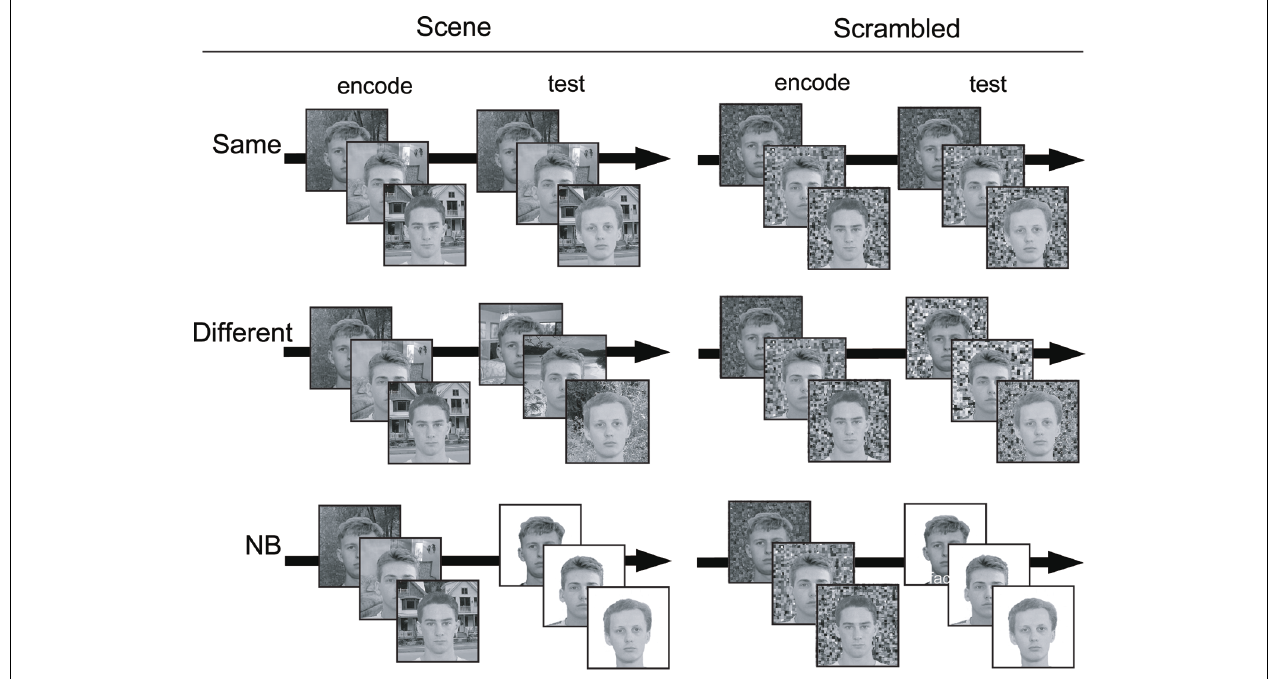
FIGURE 1 | Examples of three conditions in the current experiment. In actual procedure, the fixation point was presented after encoding images.